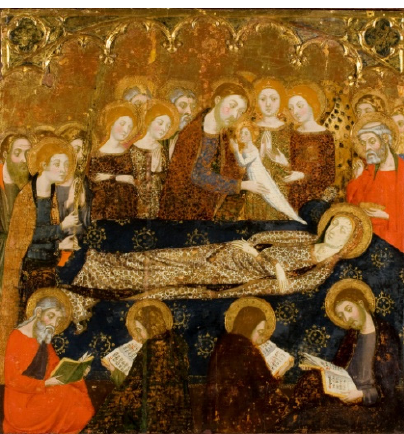
Figure 6. Jaume Serra, “Dormition”, Altarpiece of the Resurrection , 1361, Museum of Zaragoza.